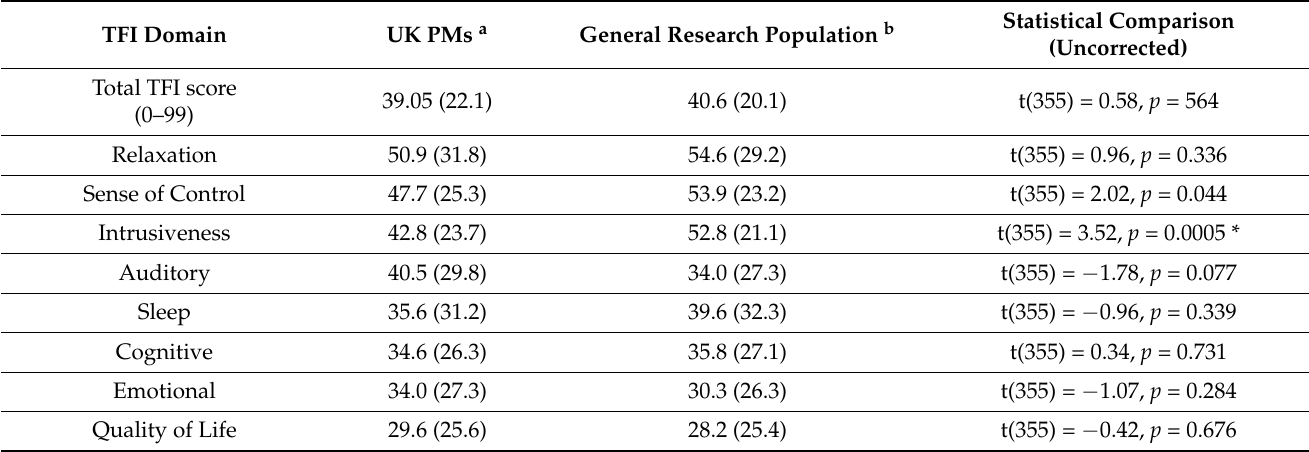
Table 3. Tinnitus functional index (TFI) mean total scores and mean subscale scores of UK professional musicians and a UK research volunteer